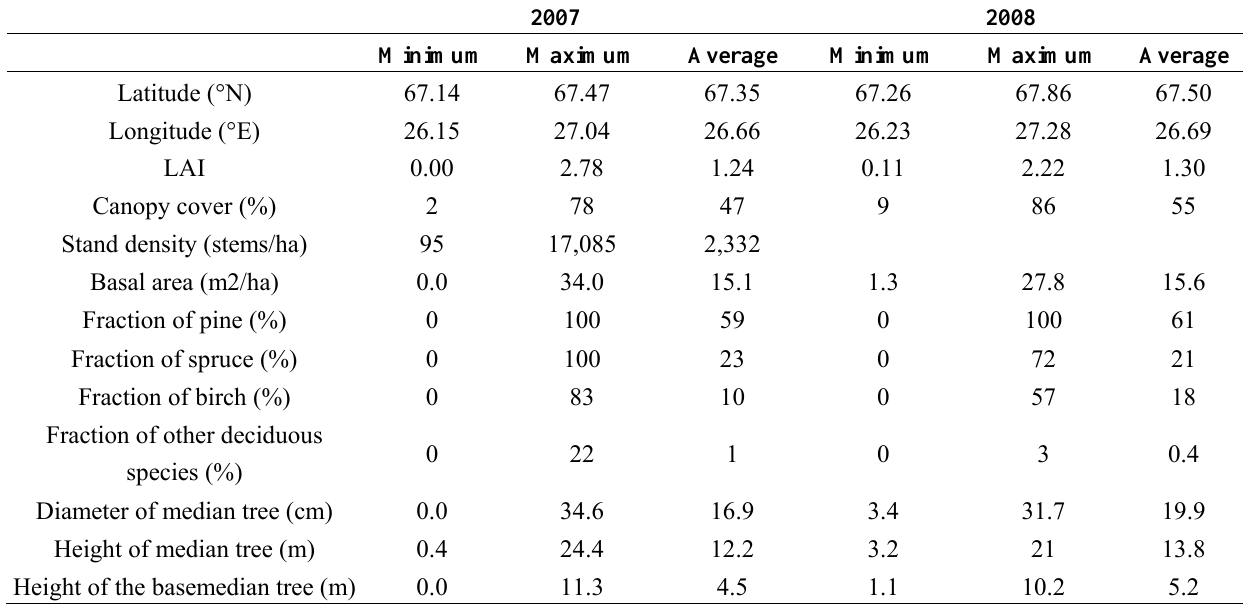
Table 1. The variation range of the location of the ground based measurements in 2007 (individual plots) and 2008